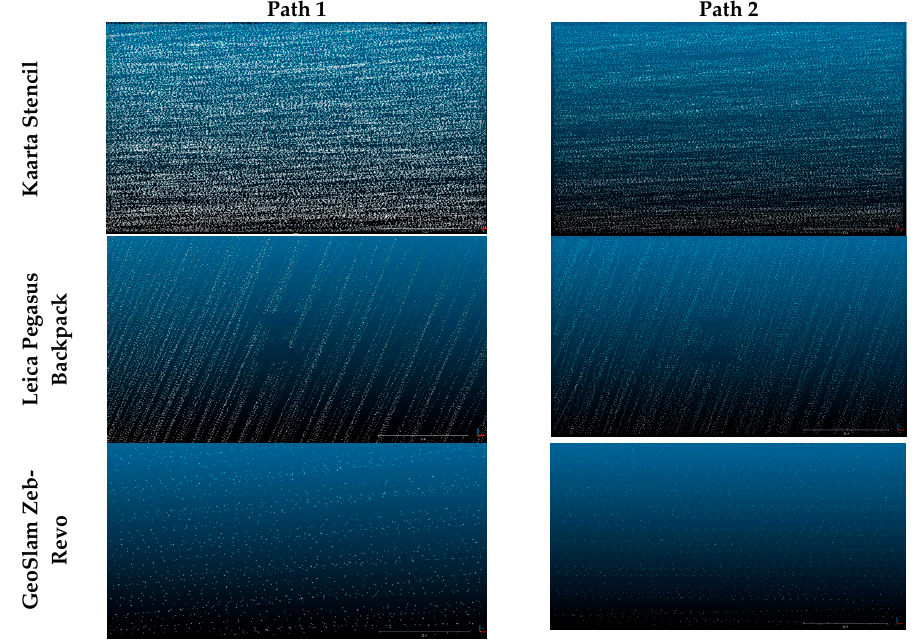
Figure 17. Various datasets in correspondence to a black and white target on a wall: in addition to the difficulty in recognizing the target, it is visible how the resolution along the vertical and horizontal directions changes dramatically.